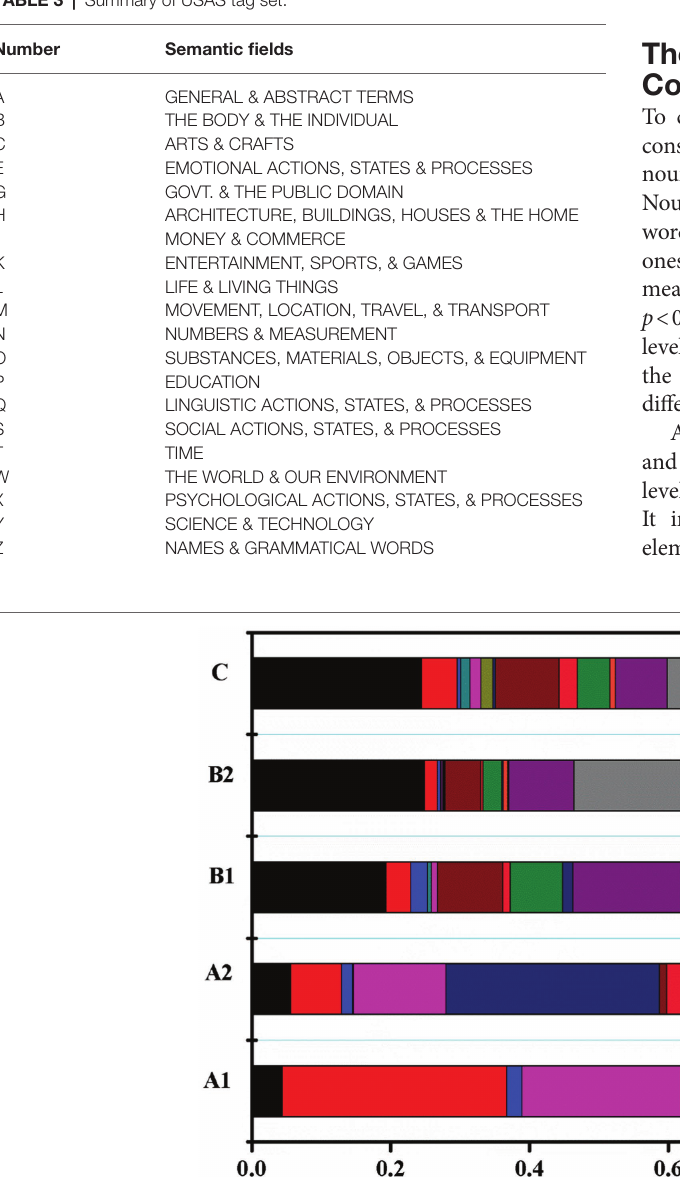
TABLE 3 | Summary of USAS tag